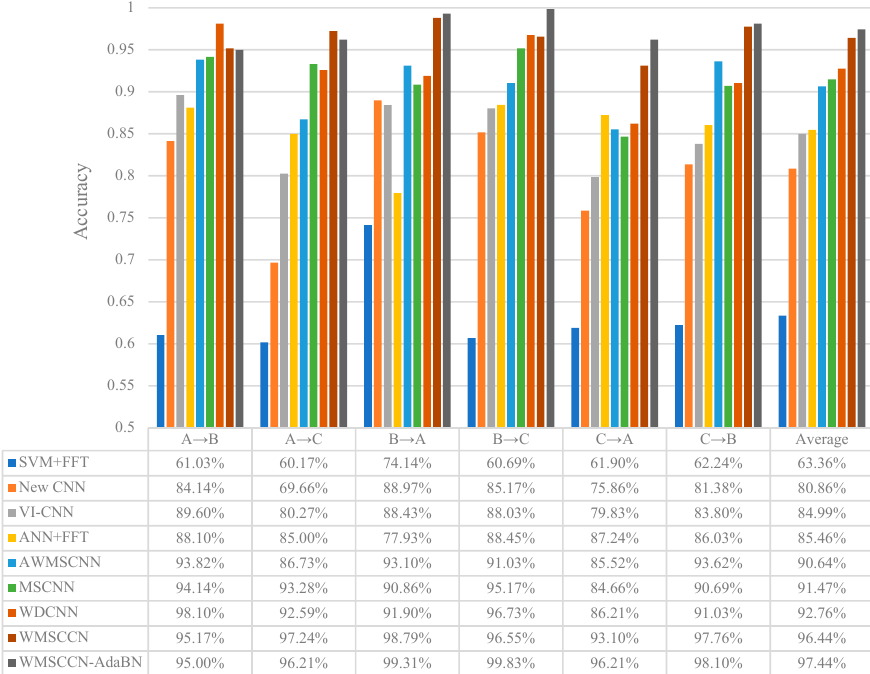
Figure 4. Comparison of diagnostic performance under different loads.